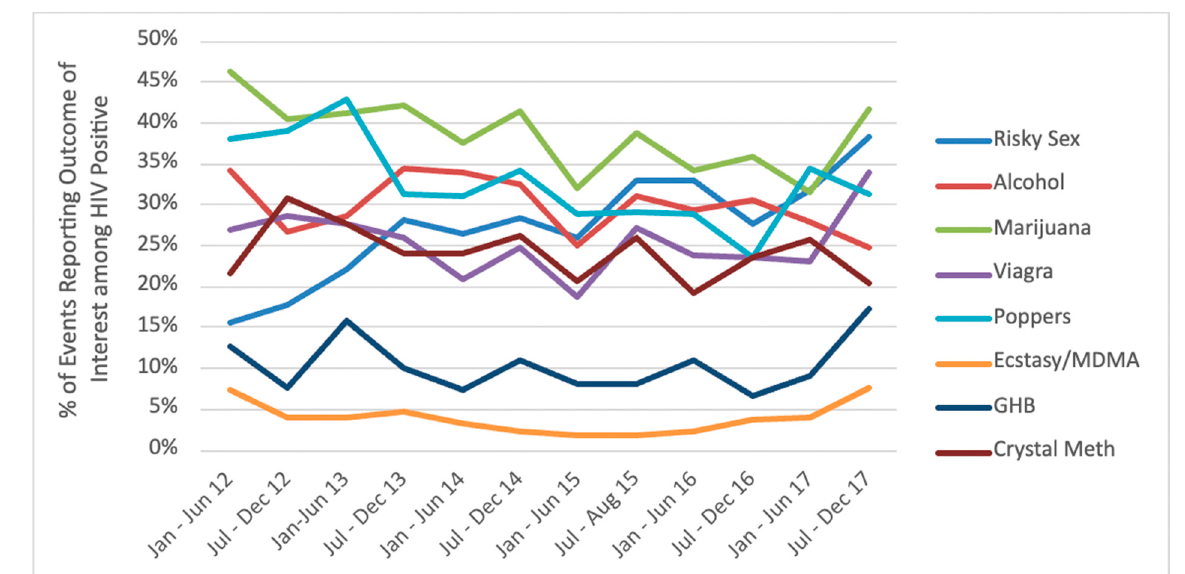
Figure 2. Percentage trends of sexual events reporting substance use and higher risk anal sex among HIV-positive gbMSM in Metro Vancouver. Notes: MDMA = 3,4-methylenedioxymethamphetamine; GHB = 3,4-methylenedioxymethamphetamine.